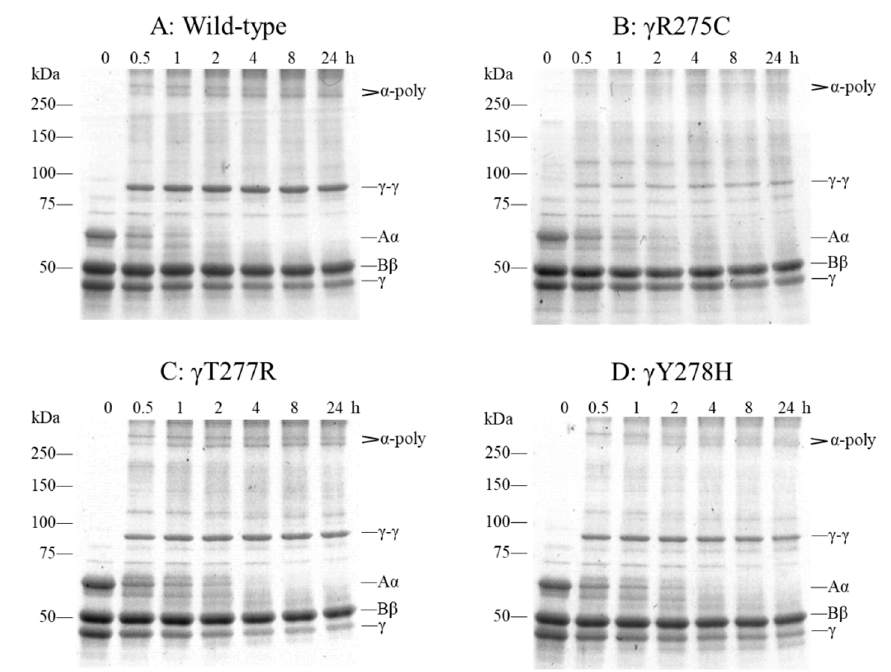
Figure 7. FXIIIa-catalyzed cross-linking of fibrinogen. Recombinant fibrinogens were cross-linked using FXIIIa for 0.5–24 h and examined in 8% SDS-PAGE gels in reducing conditions with CBB staining. Reduced fibrinogen chains (A α , B β , γ chains, α -polymer, γ - γ dimer) are indicated on the right side of each panel. ( A ) wild type, ( B ) γ R275C, ( C ) γ T277R, ( D ) γ Y278H.